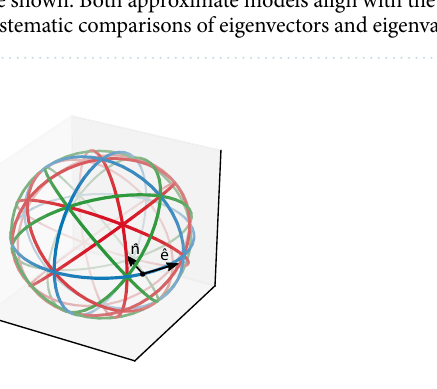
Figure 4. Circular scanning trajectories (expressed in the sample coordinate system) about a volume element n pointing in the center of the circumscribed sphere. Each trajectory describes a set of projection directions ˆ e . For better visualization, towards the center and associated tangential orientations of interferometer sensitivity ˆ they have been grouped into trajectories about the coordinate axes (blue), about their face diagonals (red) and about their space diagonals (green). Intersections of trajectories represent points of constant projection direction n at varying dark-field sensing directions e . For the present study, each trajectory is sampled at 29 equidistant ˆ ˆ n ( i ) , e ( i ) ) enumerated by i points, yielding a total of 377 distinct combinations ( ˆ ˆ